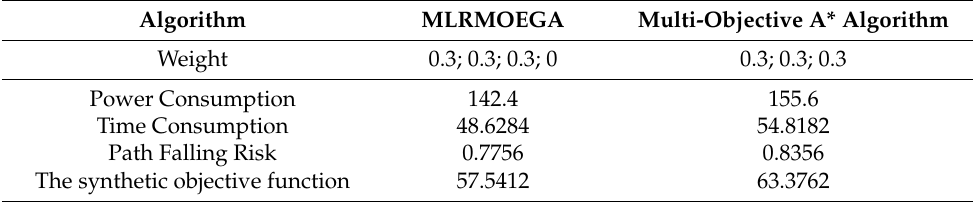
Table 9. Results of test compared with multi-objective A* algorithm.